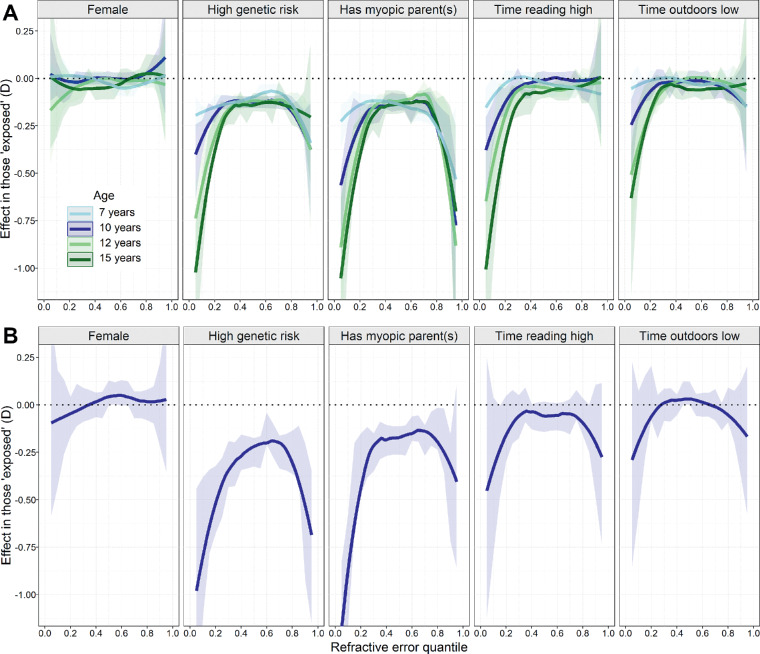
Pattern of effect sizes associated with risk factor exposure estimated with quantile regression. (A) Refractive error at the age 7 to age 15 research clinics in ALSPAC participants. (B) Refractive error at the age 9 research clinic in Generation R participants. The fitted lines indicate the effect size associated with exposure to the risk factor (shaded regions indicate 95% confidence interval of Loess fit).